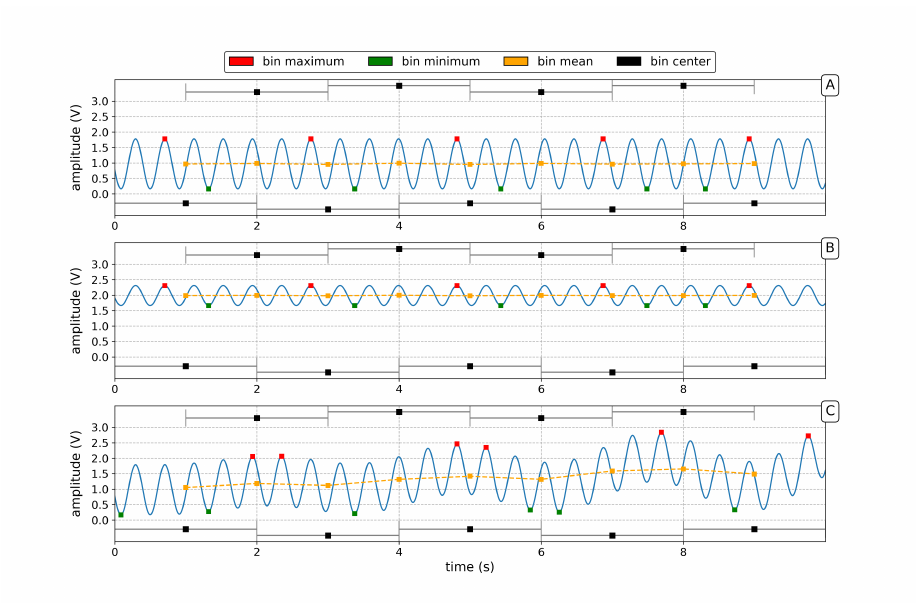
Figure 2. Schematic example of the quality measure computation for: ( A ) Single-mode, high-contrast signal; ( B ) A single-mode, low-contrast signal due to mode competition effects; ( C ) An appearing multimode operation state. Shown are synthetic signals for 2s windows with exaggerated amplitude variations and reduced frequency for demonstration purposes. Mean (orange), maximal value (red) and minimal value (green) is calculated for each bin as well as an estimate of the frequency based on zero-crossings (not shown). Bins with 50% overlap are indicated